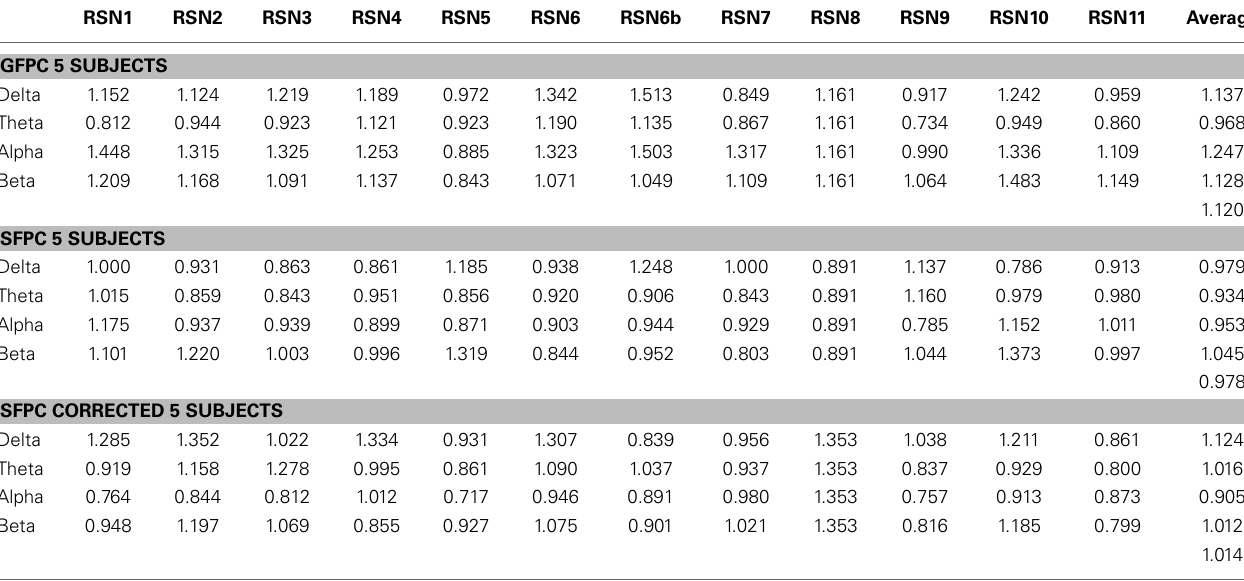
Table 1 | Correction of Table 1 in the original manuscript for GFPC and SFPC.